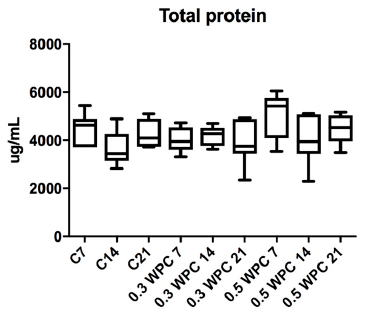
Figure 2. Total protein content in liver of rats fed with WPC-80 and the controls; C7, C14, C21, control groups; 0.3 WPC 7, 0.3 WPC 14, 0.3 WPC 21, 0.5 WPC 7, 0.5 WPC 14, 0.5 WPC 21, experimental groups.